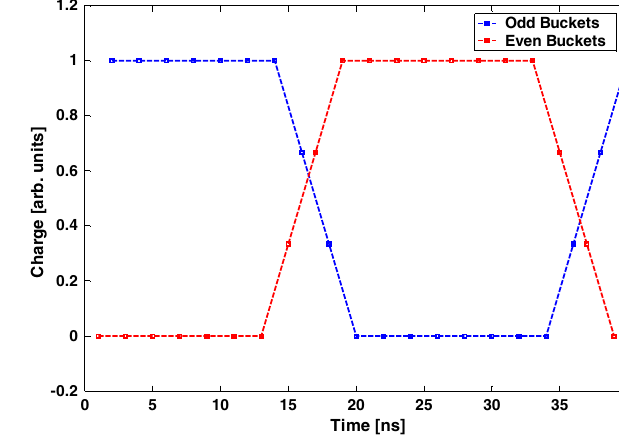
FIG. 18. Relative rms energy-spread dependence on the num- ber of the bunches in the train.